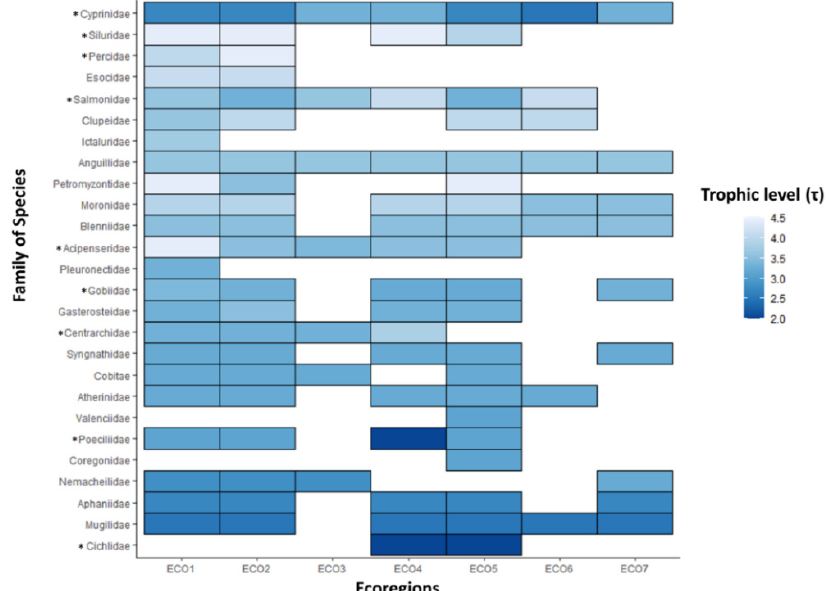
Figure 2. Geometrical rectangle visualization of the trophic level mean ( τ mean ) value of each fish family per ecoregion (* at least one introduced species within the family; τ max : light blue; τ min : dark blue; N = 157). Ecoregions are according to Zogaris and Economou [35] as follows: ECO1: Thrace, ECO2: Macedonia-Thessaly, ECO3: Southeastern Adriatic, ECO4: Western Aegean, ECO5: Ionian, ECO6: Crete, ECO7: Eastern